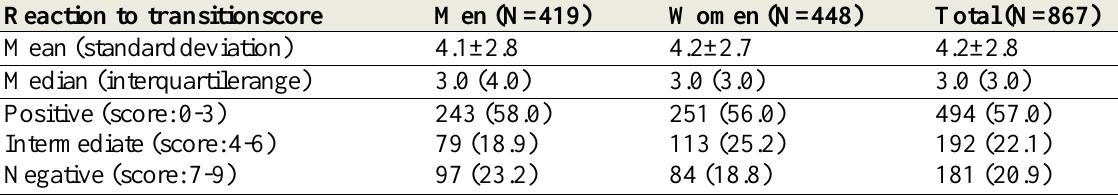
Table 1. Distribution of reaction to political and socioeconomic transition scores ina representative sample of primary health care users in Gjilan region, Kosovo,